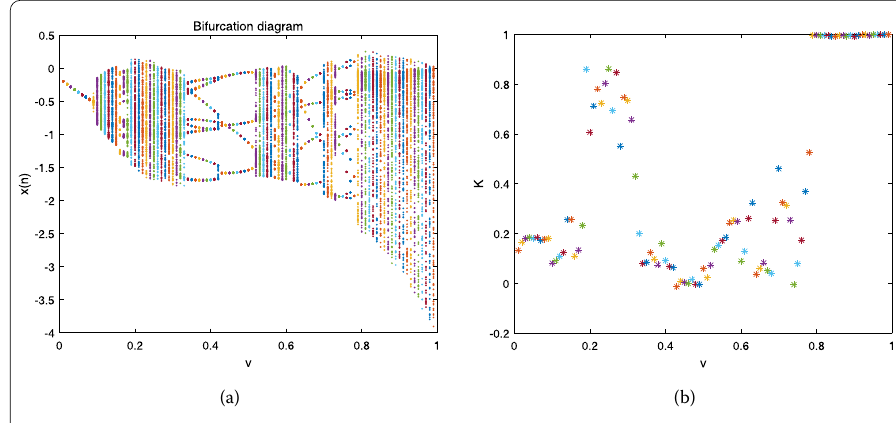
Figure 4 Bifurcation diagram and K median value. The bifurcation diagram ( a ) and K median value ( b ) of system (10) with a = 1, b = 1 versus fractional order v